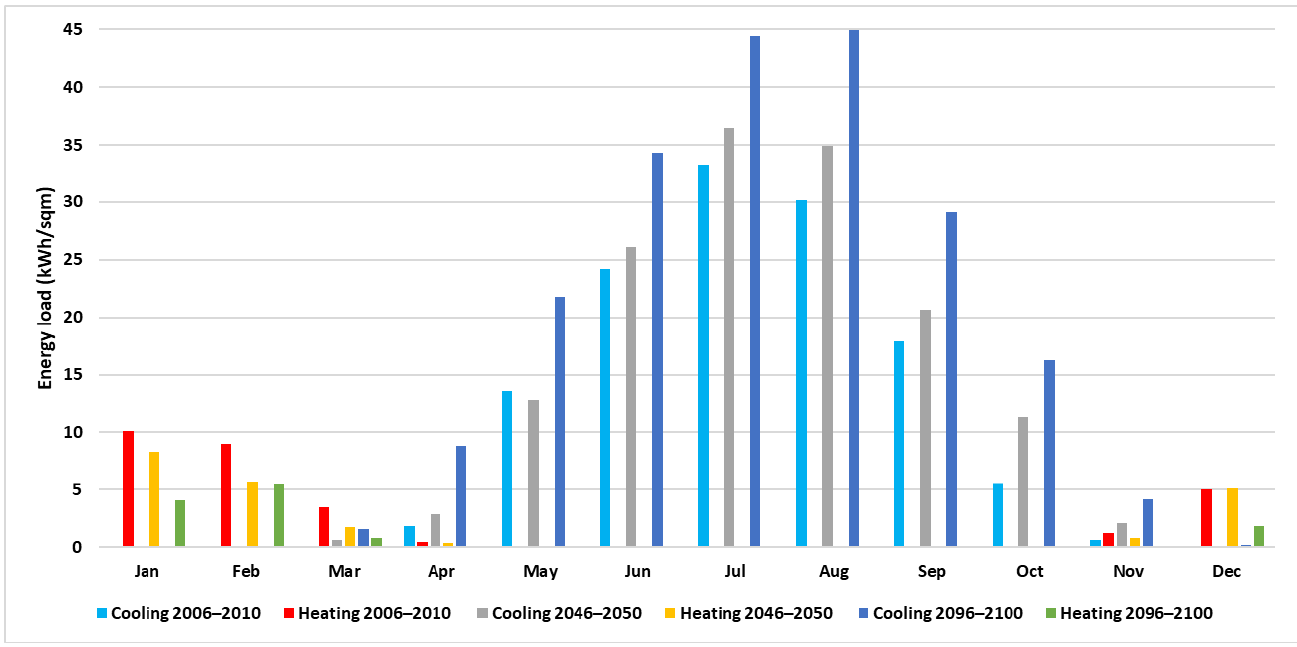
Figure 7. Whole-building heating and cooling loads — cooling and heating season.